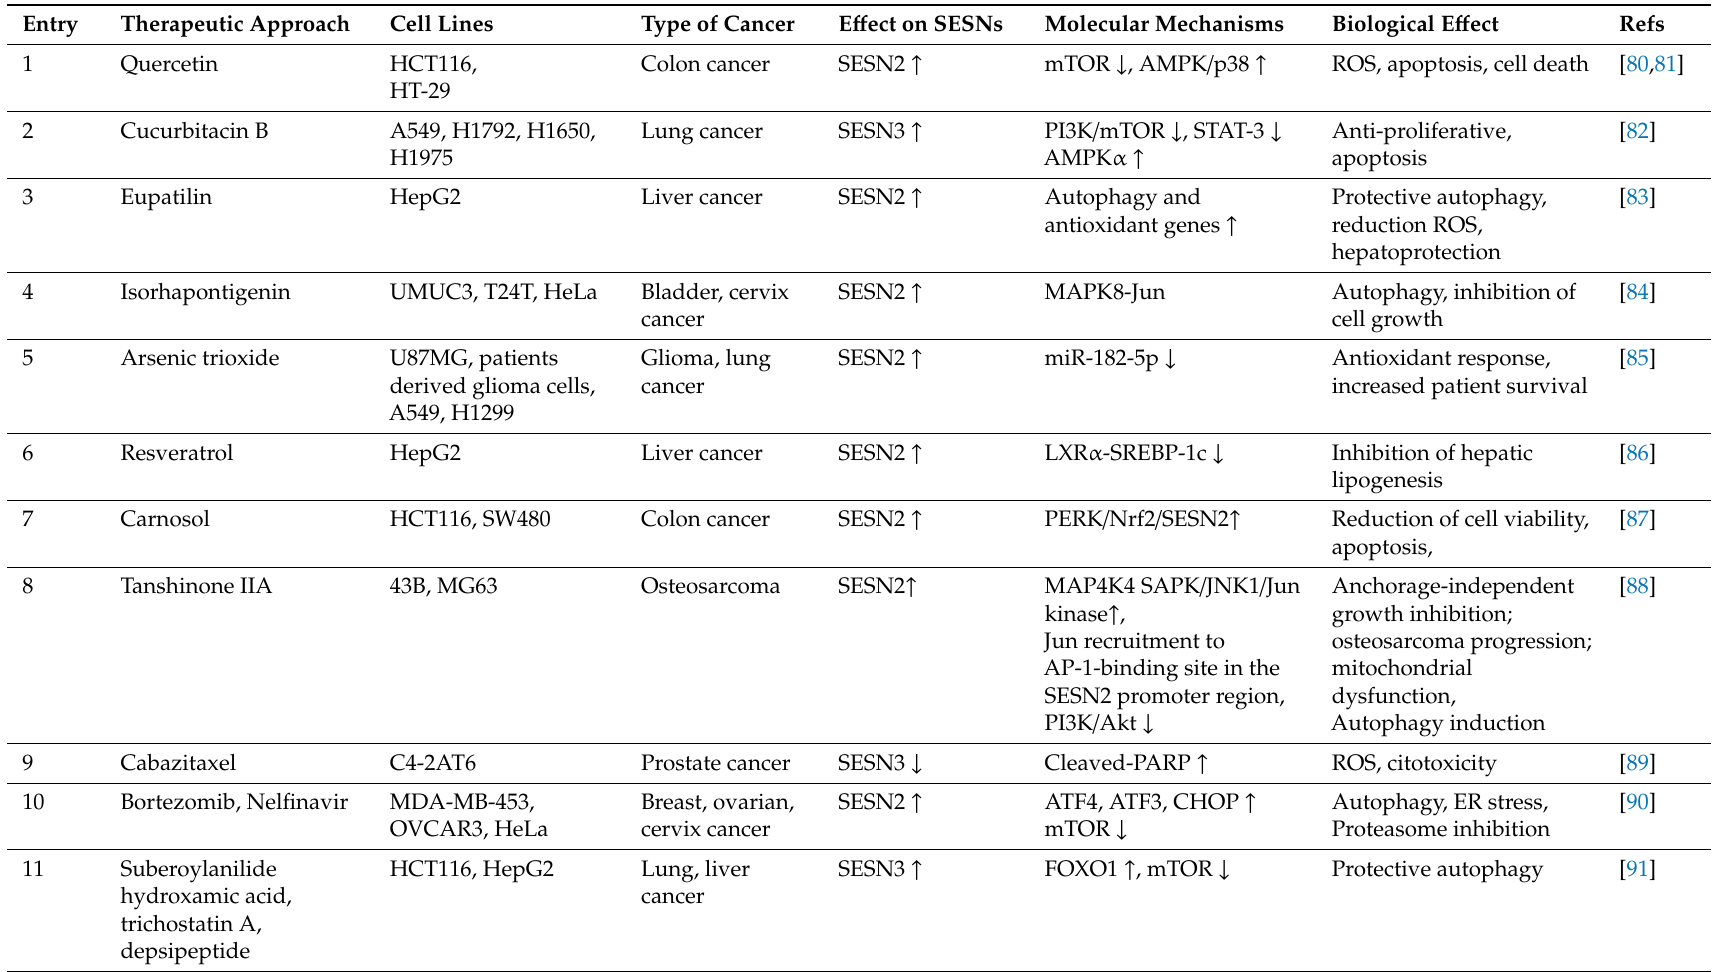
Table 1. Major current cancer treatments modulating SESNs